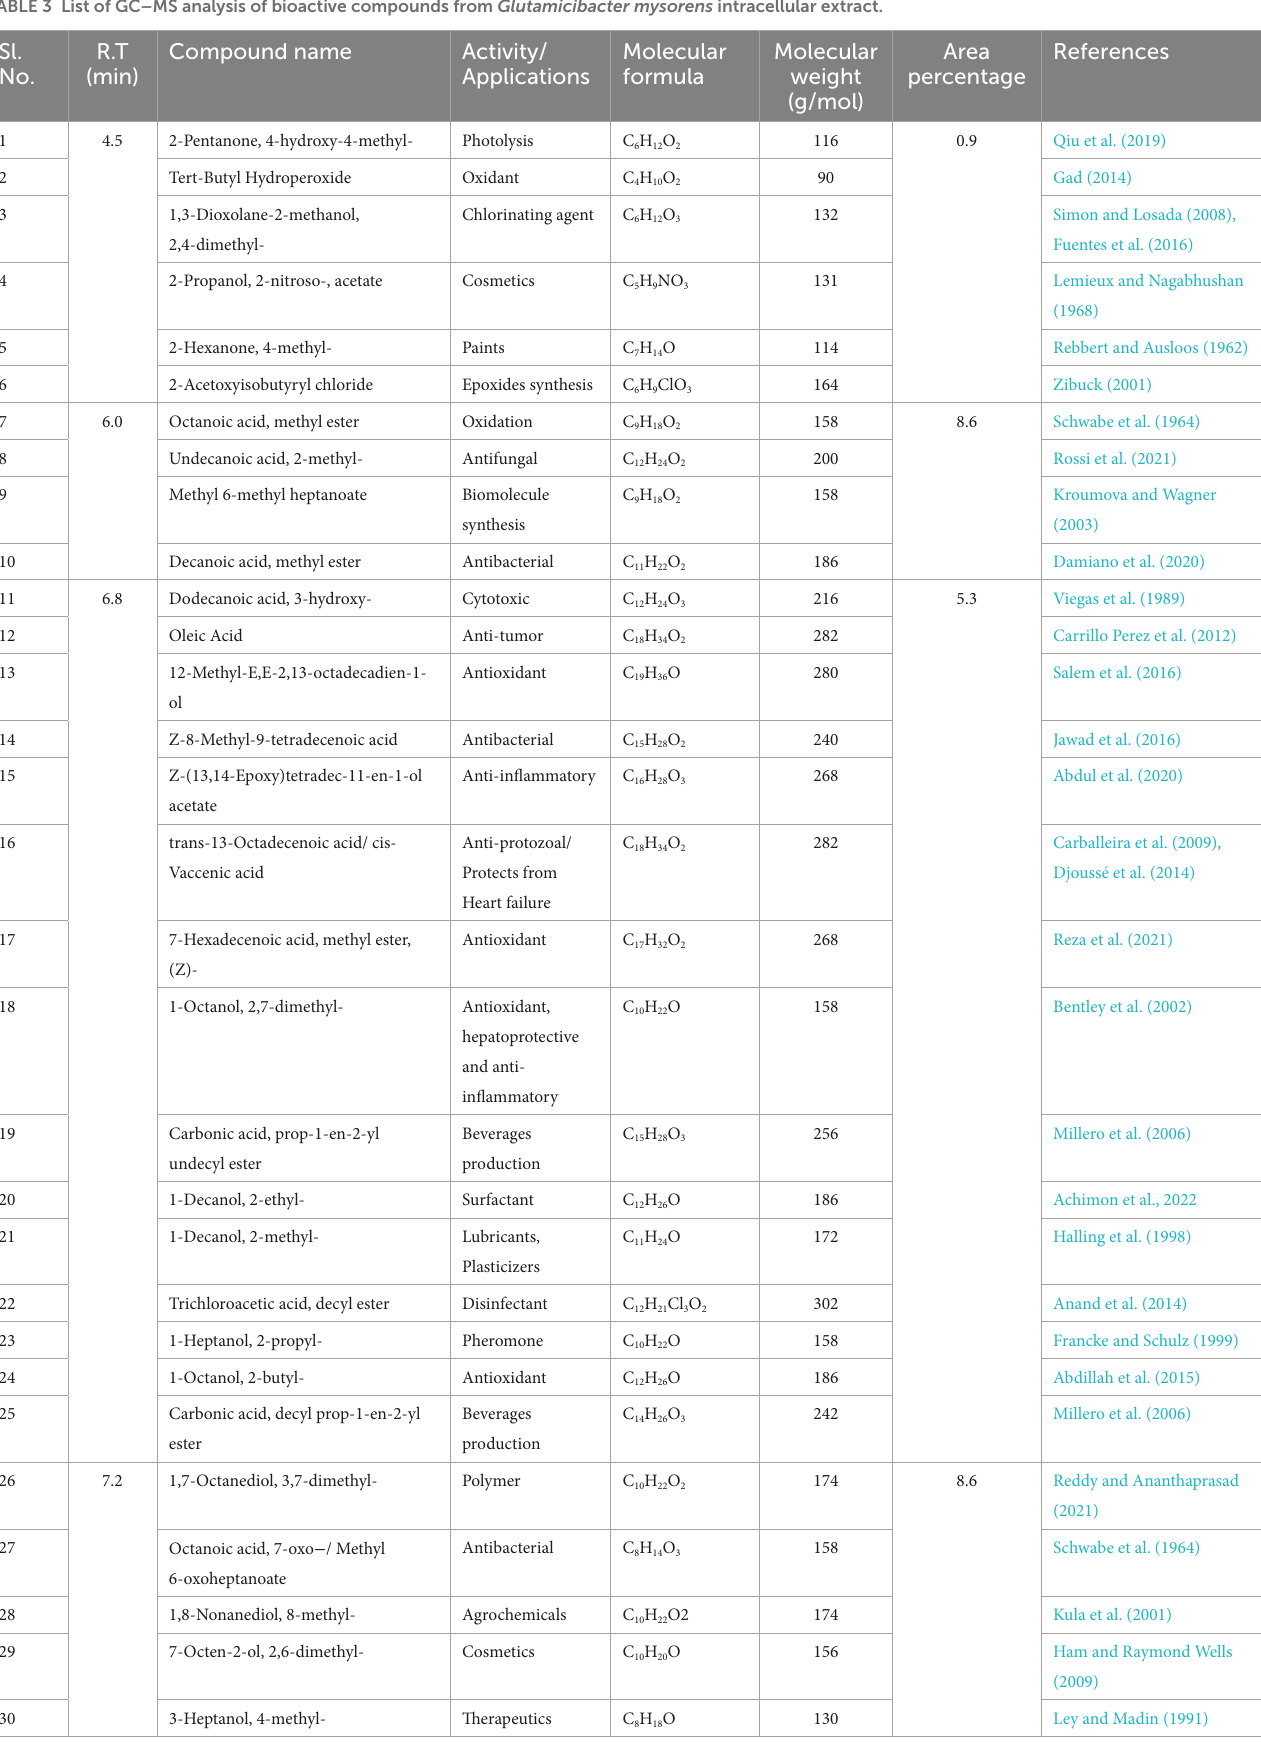
TABLE 3 List of GC–MS analysis of bioactive compounds from Glutamicibacter mysorens intracellular extract. Sl.